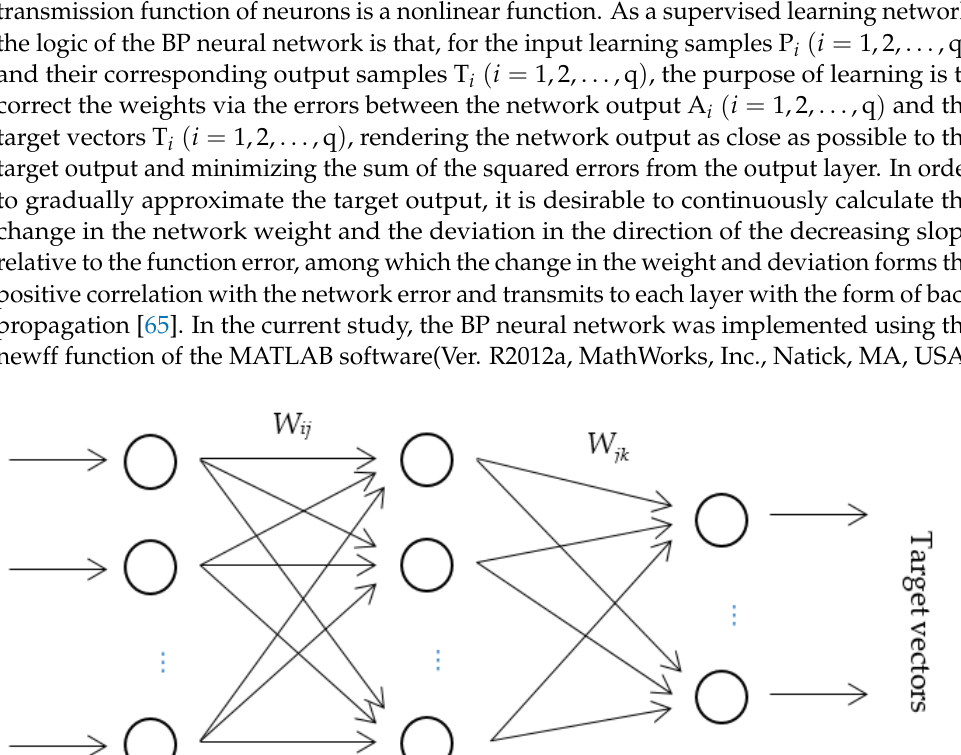
( b ) Figure 3. Water extraction by the NDWI method: ( a ) water mask and ( b ) after water extraction. 2.3.4. BP Neural Network